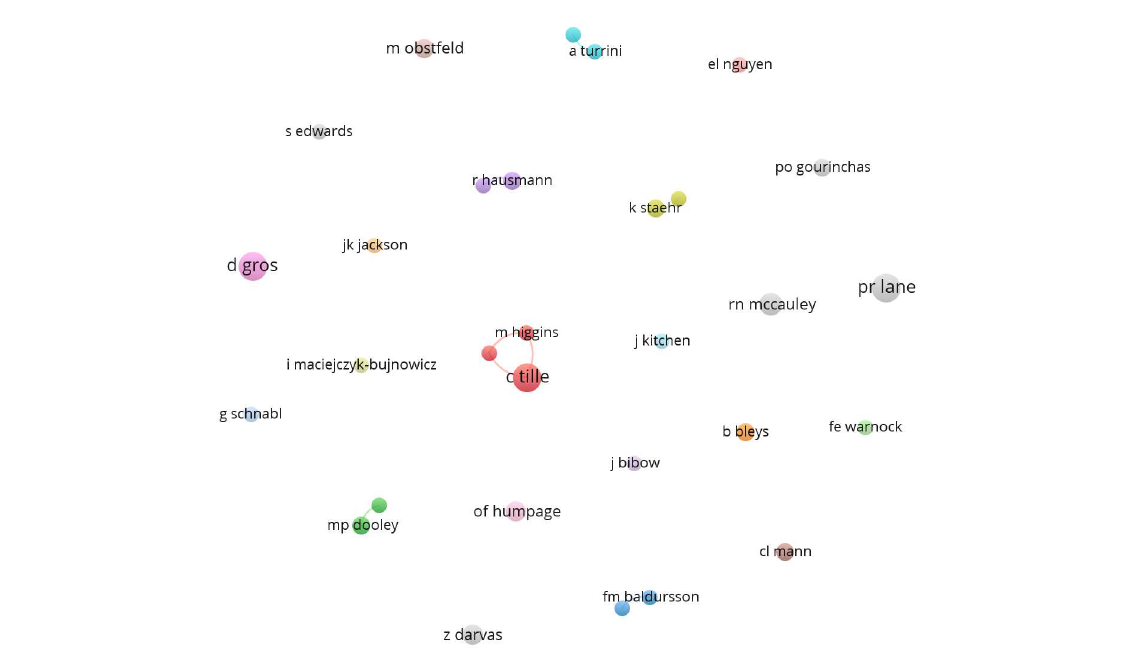
Figure A2. Bibliometric map of scientists on the query “Net international investment position” searched in the publications’ topics and keywords according to Google Scholar database in